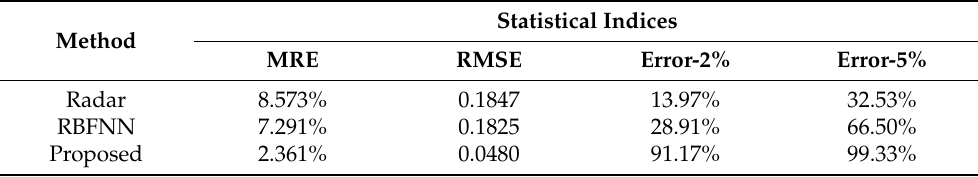
Figure 14. Operation effect diagram of the detection method of ESST-RBFNN based on the validation data. Table 2. Statistical error comparison.